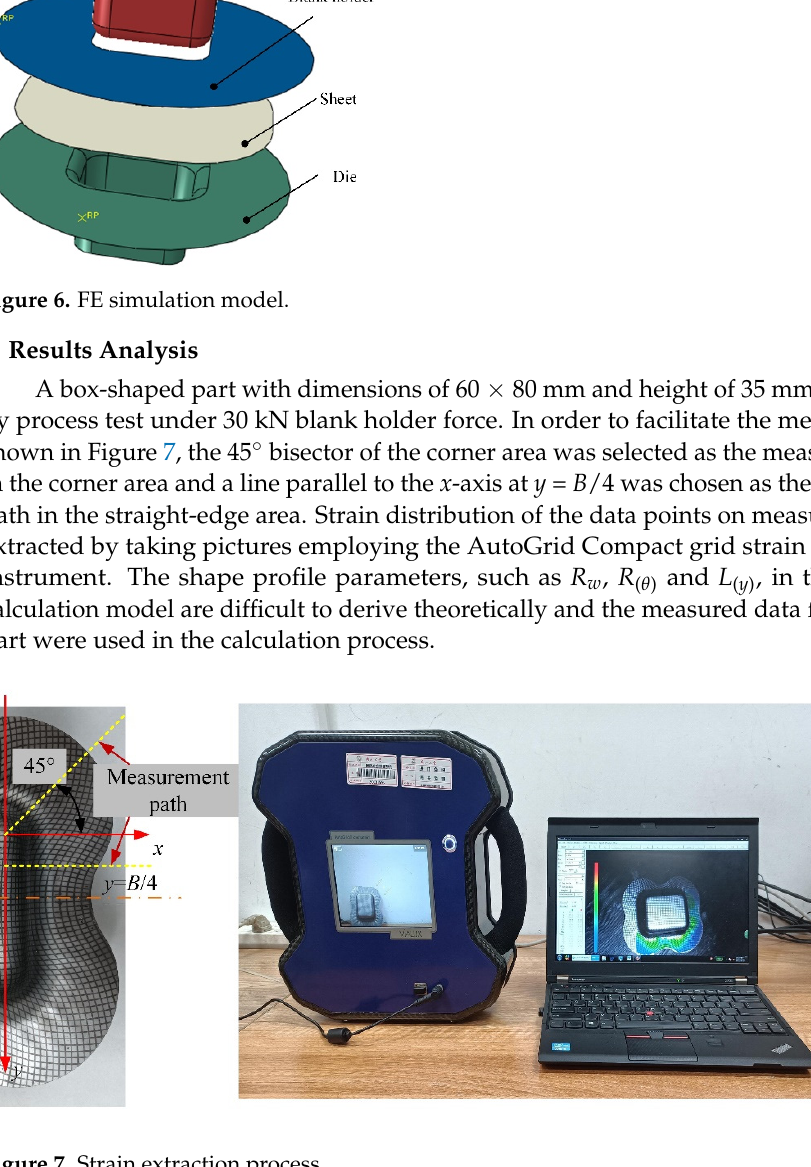
Figure 7. Strain extraction process.